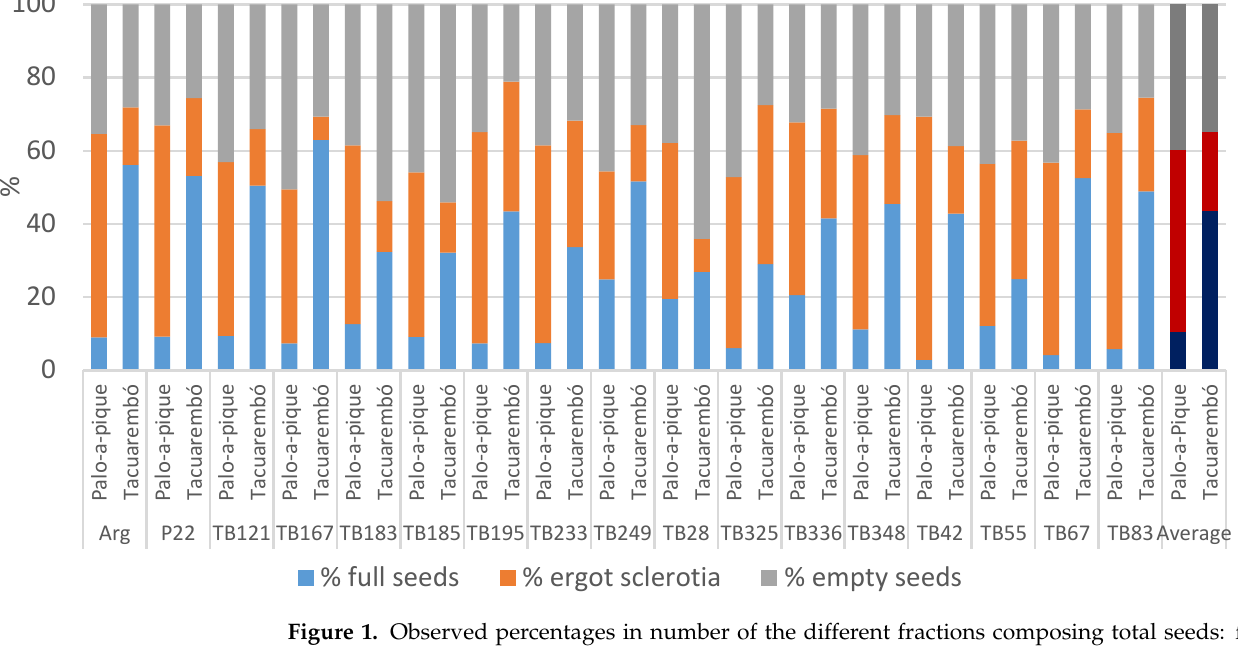
Figure 1. Observed percentages in number of the different fractions composing total seeds: full seeds, ergot sclerotia, and empty seeds, summarized by genotype and location. Location averages represented in darker